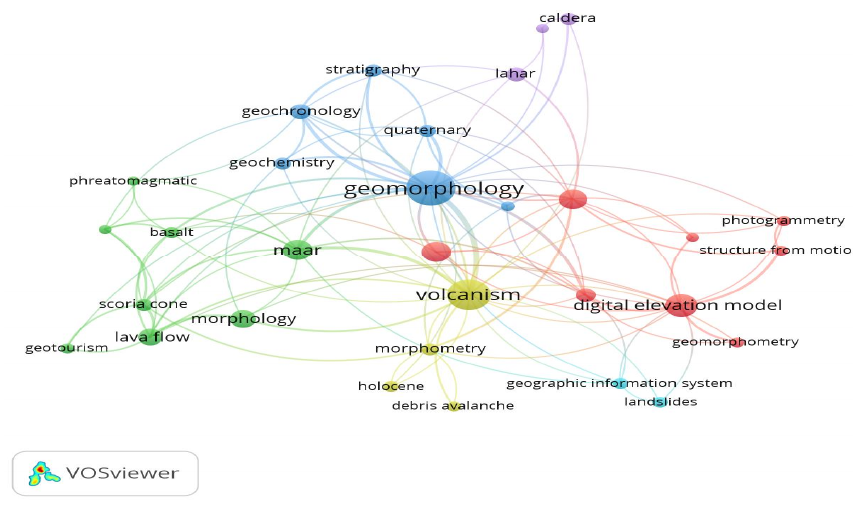
Figure 3. Co-occurrence bibliometric map of author keywords.